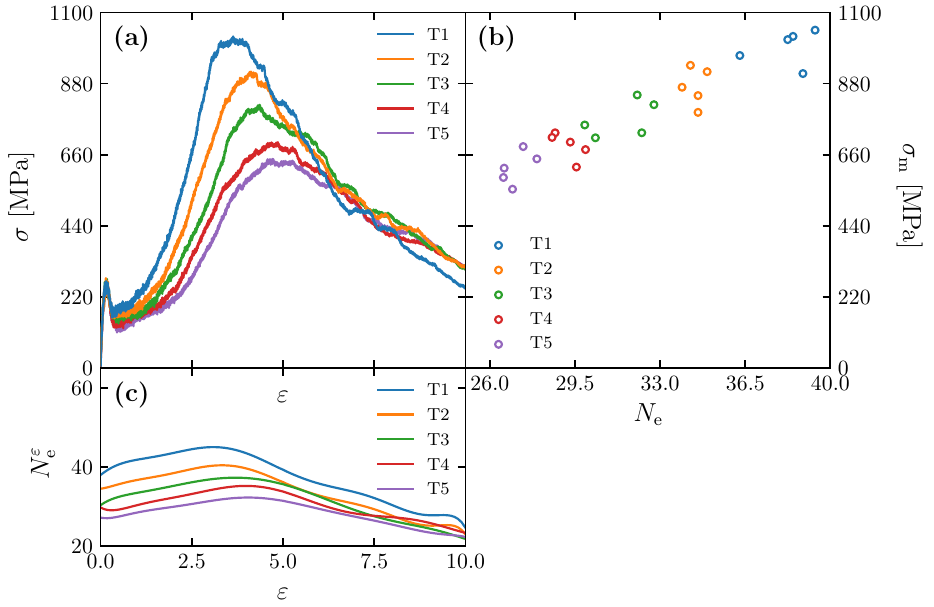
Figure 6. ( a ) Stress–strain ( σ - ε ) curves of simulation cells of T1–T5; ( b ) N e as a function of strain for the simulation cells with various annealing times; ( c ) maximum stress ( σ m ) as a function of N e for the simulation cells with various annealing times ( M n = 32.8 kg/mol, Kuhn segment length of 8